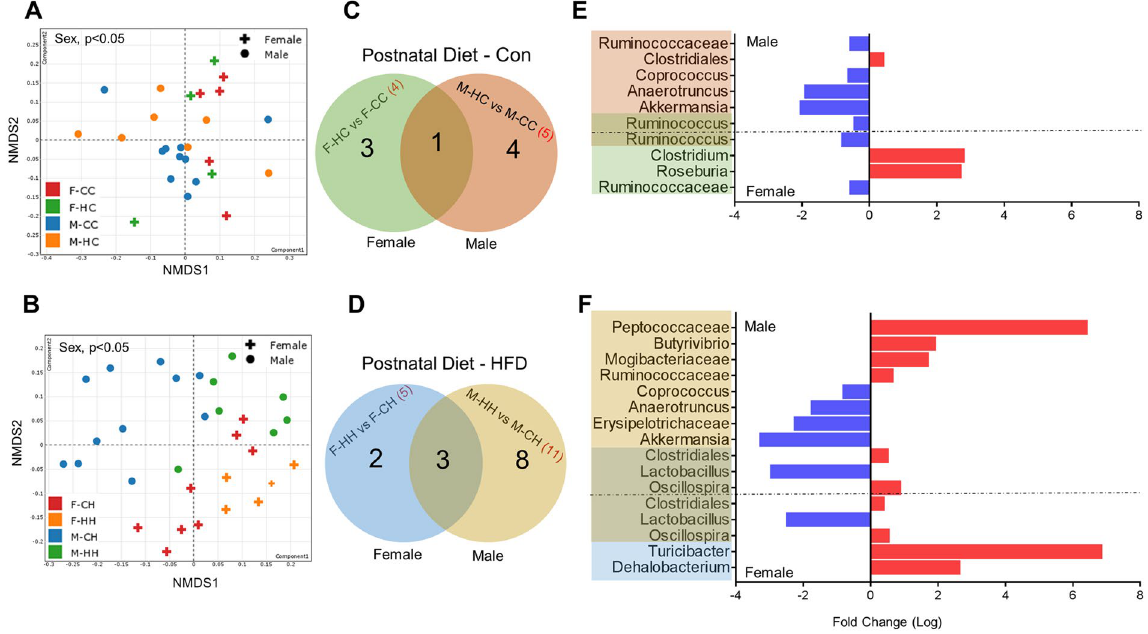
Figure 3. Effects of maternal HFD and offspring sex on bacterial diversity and abundance. Non-metric multidimensional scaling (NMDS) ordination of the OTU dissimilarity matrix (Bray-Curtis) of β -diversity values in offspring fed ( A ) control or ( B ) HFD. Venn diagrams representing the numbers of bacterial genera showing significant change (via DeSeq2) due to maternal HFD in offspring of either sex within ( C ) control or ( D ) HFD contexts postnatally. ( E,F ) Bar charts showing fold change of differentially expressed bacterial genera in male and female offspring. Note that male offspring exposed to HFD postnatally show greater reconfiguration of microbiota. Statistical differences between the groups were determined using inverse binomial tests using Deseq2 (p < 0.05).